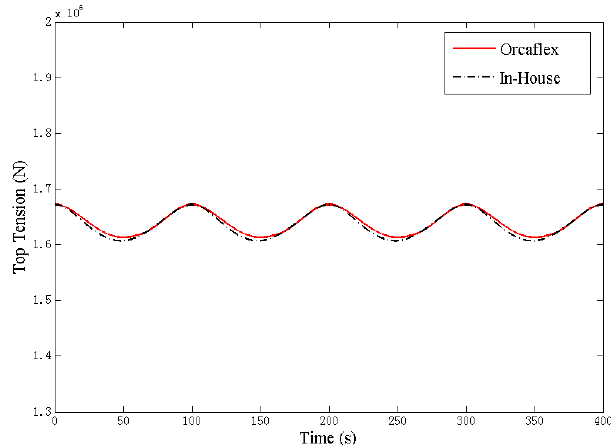
Figure 4. Single mooring line under the horizontal harmonic excitation.